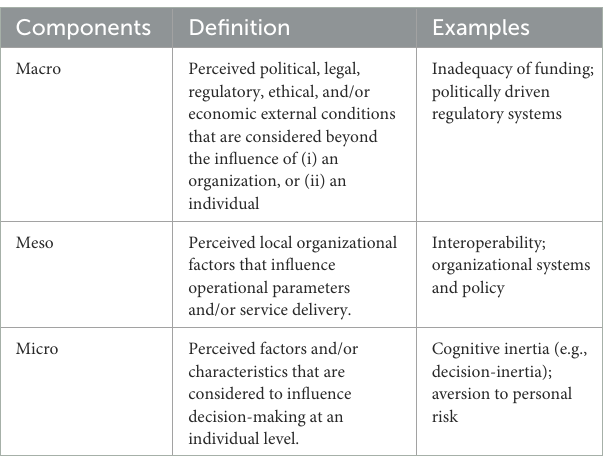
TABLE 1 An extract of the key terms used to identify relevant literature. TABLE 2 Definition of the macro-, meso-, and micro- components used to categorize eligible articles. Definitions have been adapted from Smith and Barrett